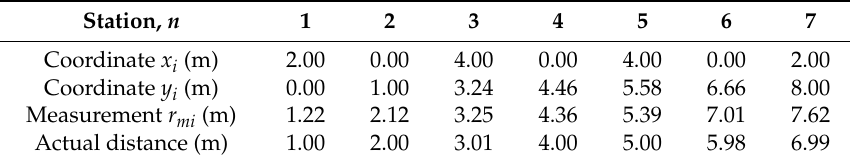
Table 3. The experimental data for the indoor experiment ( k = 2.5, P = 96%, σ i = 0.3 m). Station, n